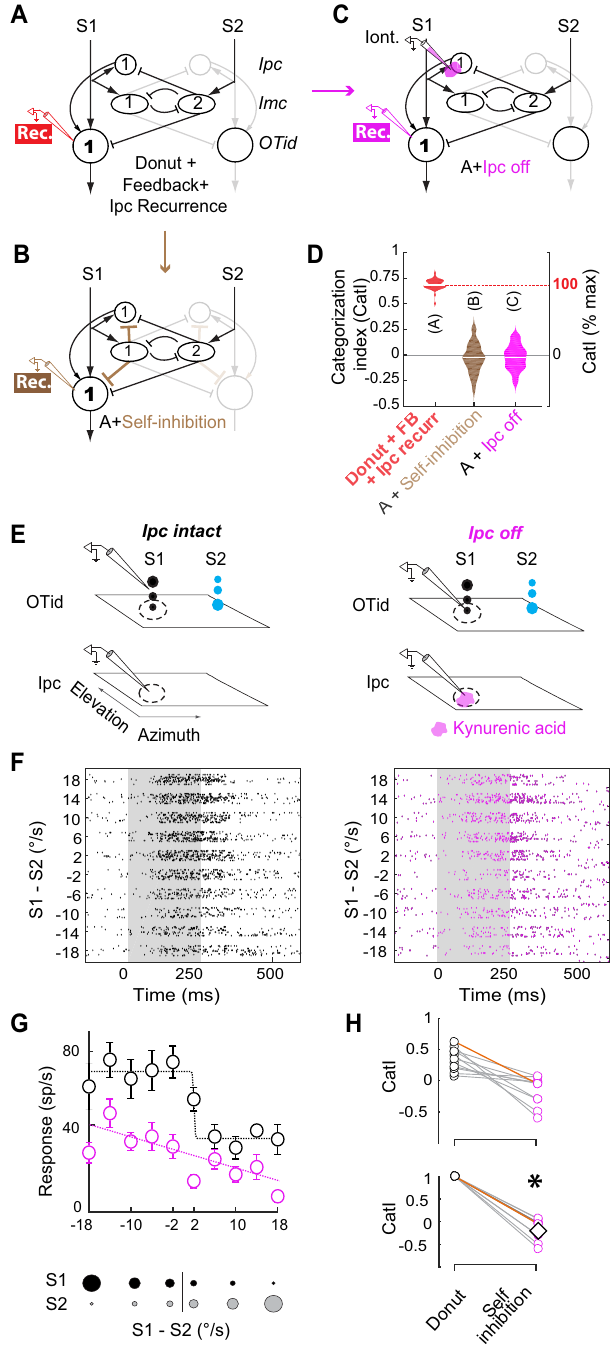
correction; Fig. S3I, J-red; Methods). The mean strength of